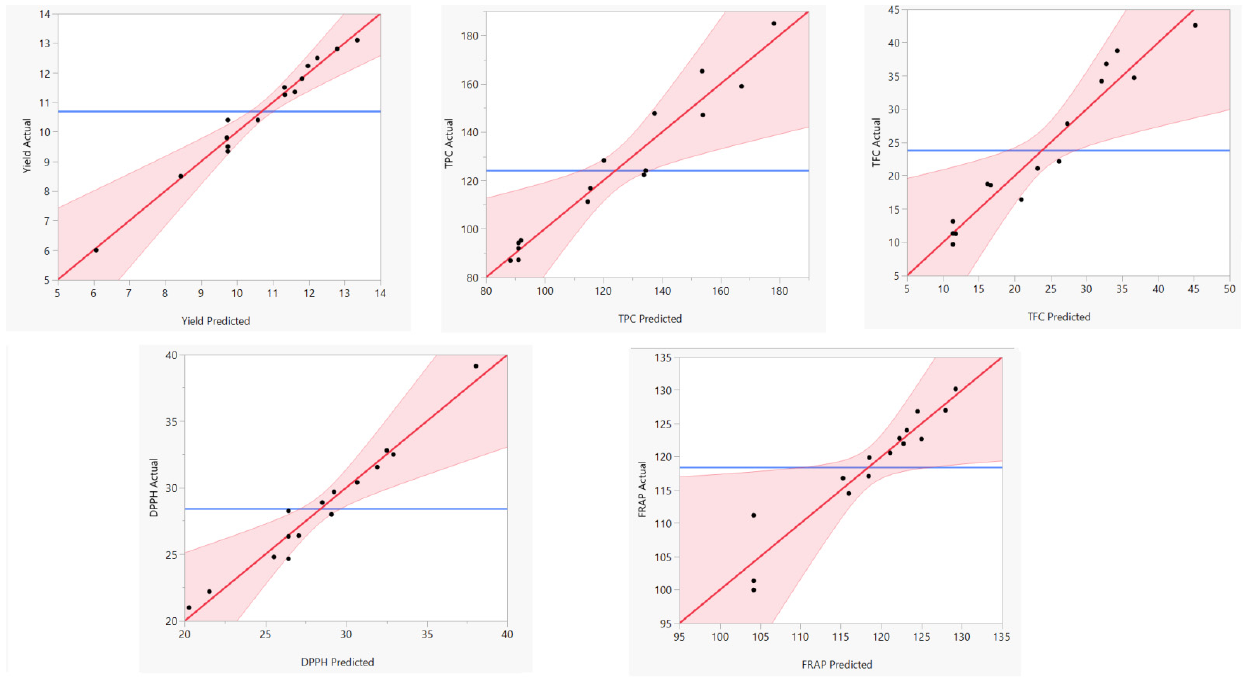
Figure 1. The curve of the actual values in terms of the predicted values.